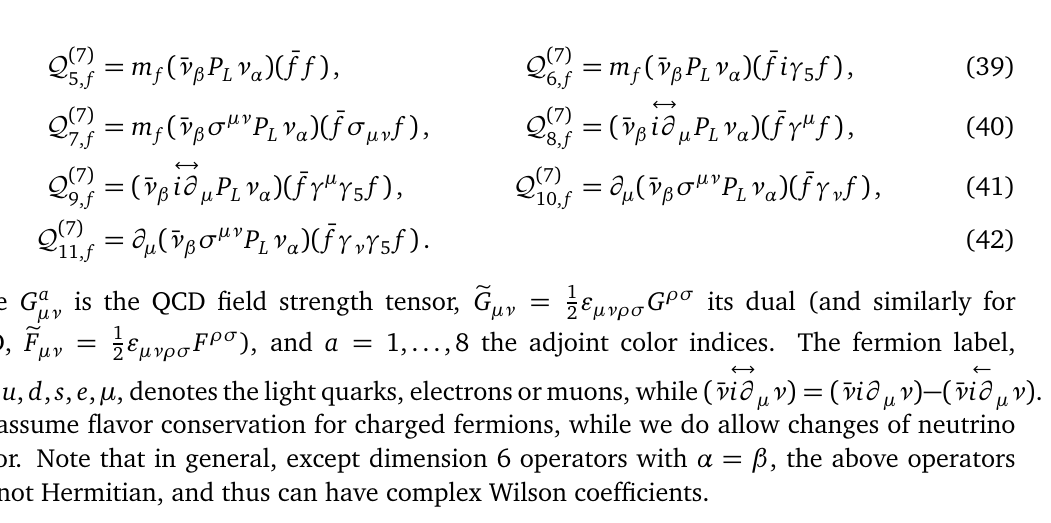
Figure 16.1: Recoil spectrum at COHERENT adding the new scalar NSI ing Λ ∼ 2 GeV. The red line is the detector energy